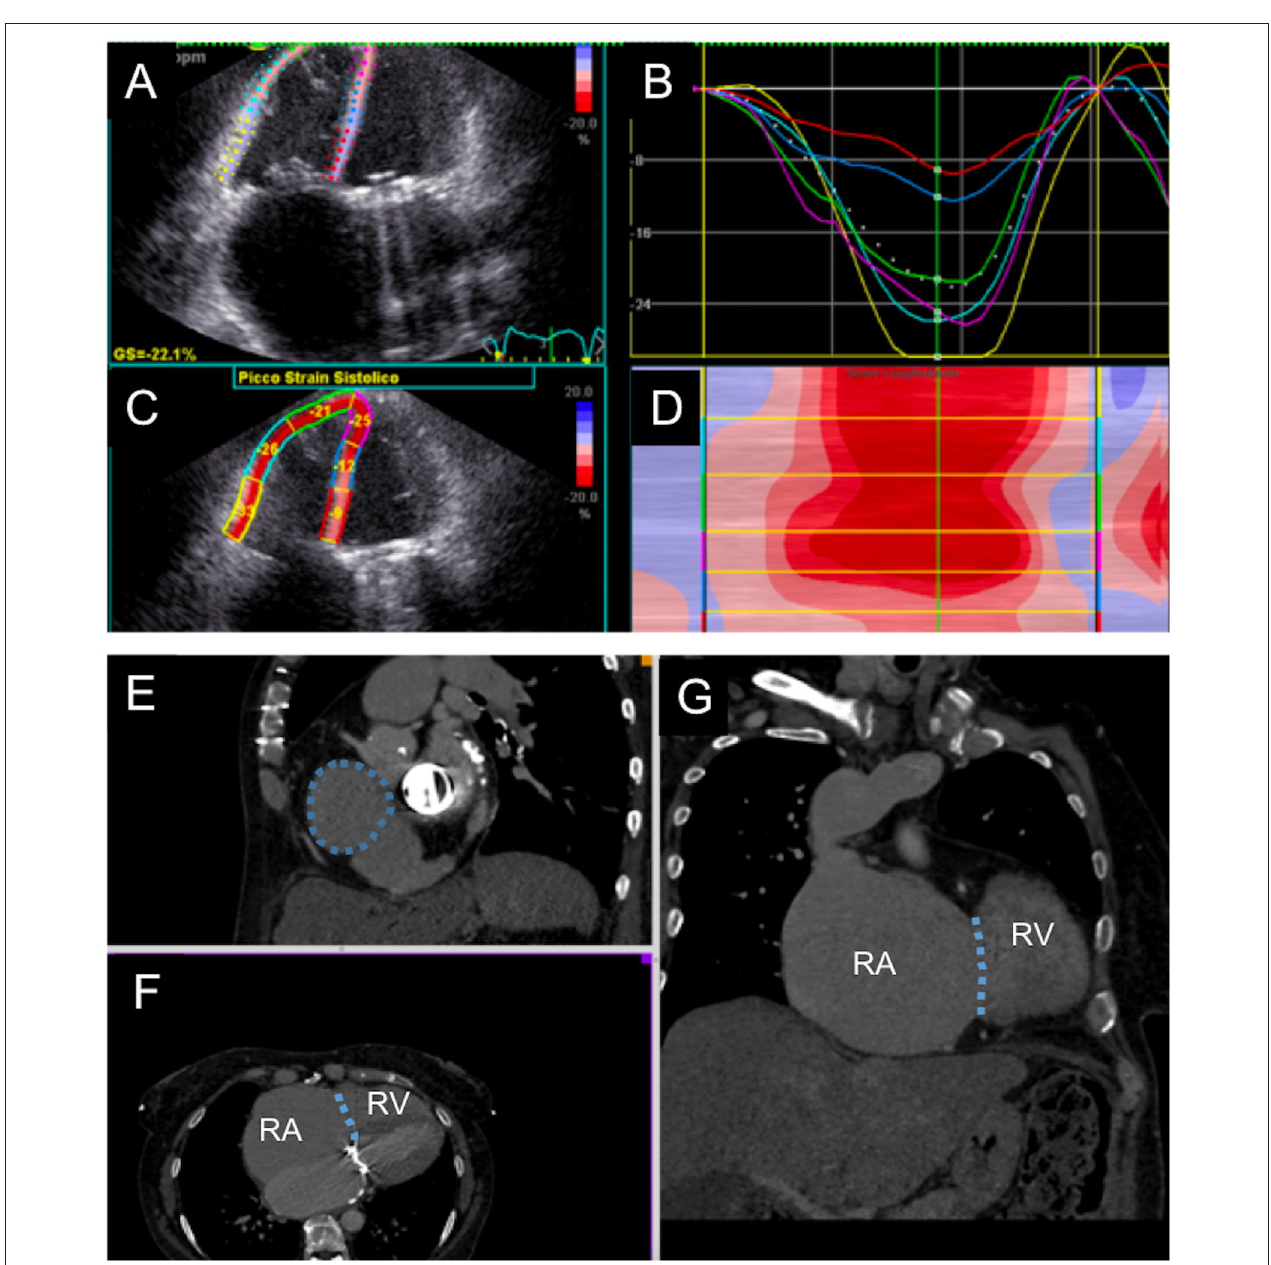
FIGURE 3 | Multimodality evaluation for percutaneous tricuspid valve replacement. (A–D) Echocardiographic evaluation of right ventricular function with semi-automated strain measurement. (E–G) Computed tomography cardiac chamber and tricuspid valve evaluation; the patient presented with severe right ventricular (RV) and right atrial (RA) dilatation; tricuspid annulus is highlighted with dotted